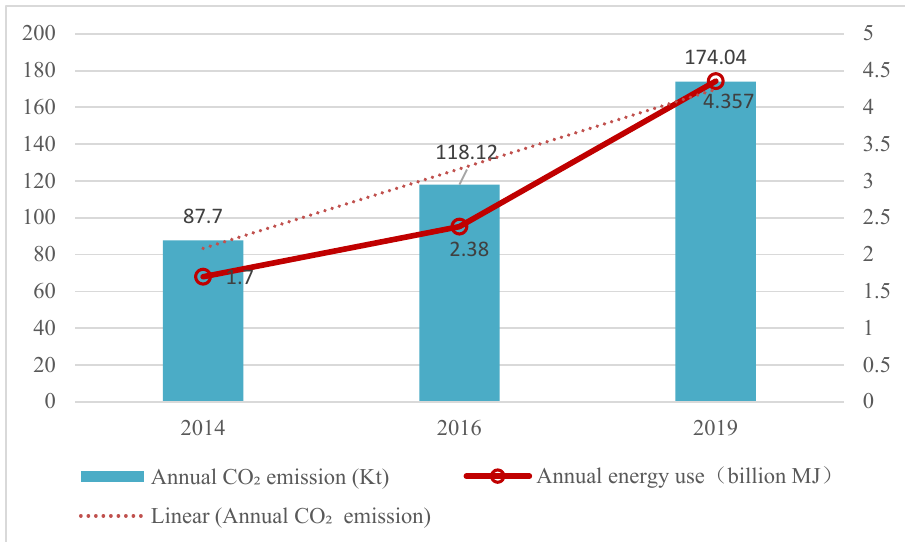
Figure 3. Annual energy uses and CO 2 emissions of tourism in the study area.